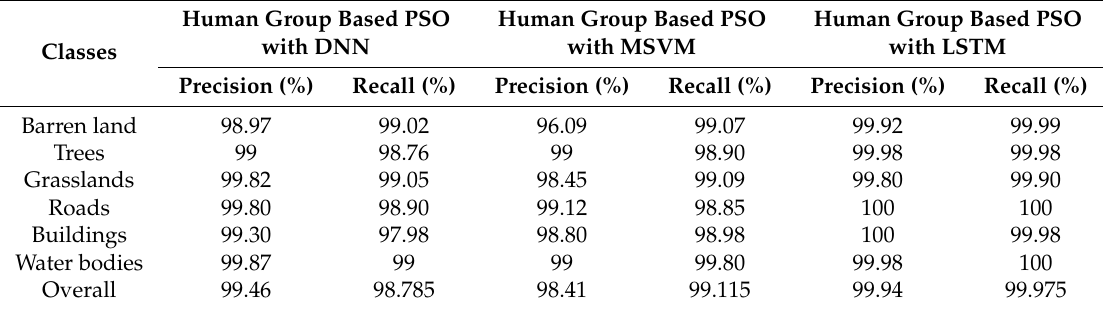
Table 9. Performance investigation of the proposed model with di ff erent classifiers on Sat 6 dataset by means of recall and precision.